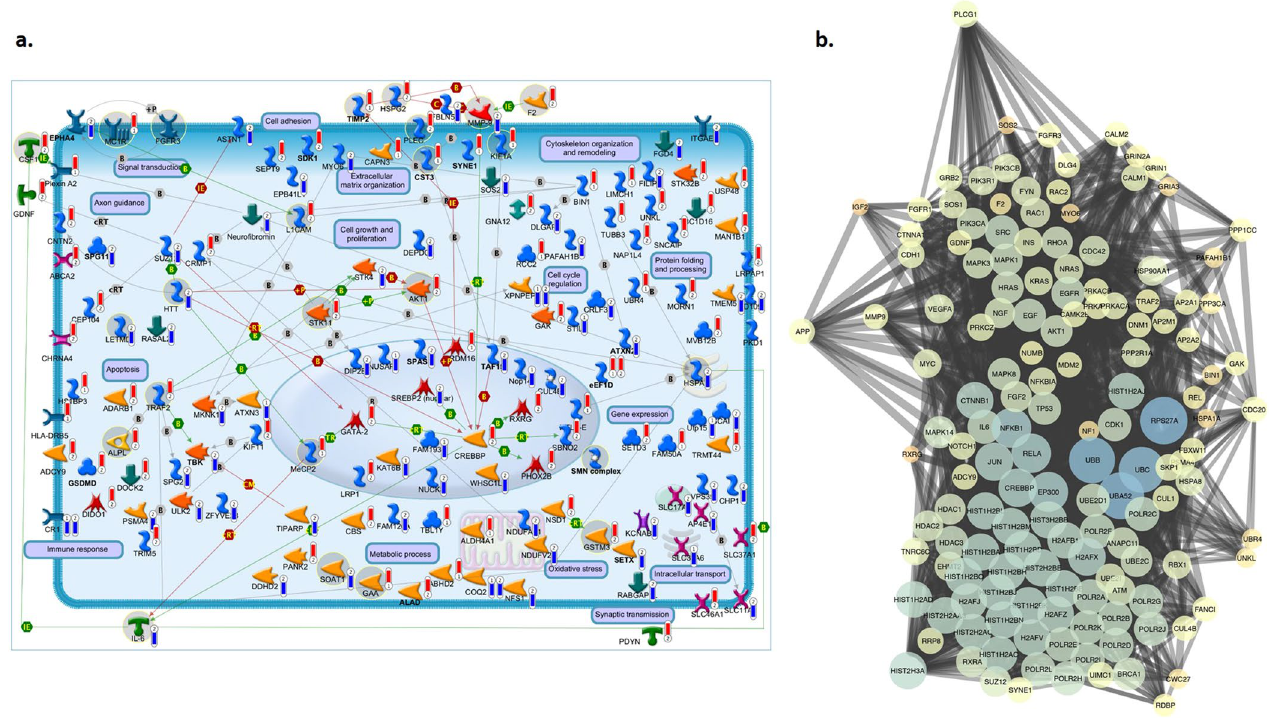
Figure 4. Definition of SALS subtype-specific genomic signature using pathway and network analyses. ( a ) A representative illustration showing the functional correlation between SALS associated CNV-driven genes and their biological processes. Interaction map represents the most promising candidate genes showing a positive correlation between gene expression and underlying genomic changes, grouped on the basis of the main biological processes associated with them. The map was created using the MetaCore Pathway Map Creator tool (GeneGo). Gene expression and CNV values are presented on the map as ‘thermometer-like’ figures with SALS1 patients data represented as thermometer #1 and SALS2 patients as #2. Genes associated with overexpression and CNV gain regions are labeled with red dots while genes associated with downregulated expression and homozygous or heterozygous deleted CNVs are labeled with blue dots. A detailed legend for the network objects is shown in the Supplementary Fig. 1. ( b ) Functional network of known and predicted interactions of the most promising candidate CNV-driven genes. The network was produced by the Search Tool for the Retrieval of Interacting Genes/Proteins (STRING) v10 (http://string-db.org/) using default settings. Proteins are represented by spheres. Lines linking proteins indicate evidence for interactions: a red line indicates the presence of gene fusion (genes that are sometimes fused into single open reading frames); a green line – gene neighborhood (genes that reside within 300 bp on the same strand in the genome); a blue line – co-occurrence (gene families whose occurrence patterns across genomes show similarities); a purple line - experimental evidence (interaction extracted from protein-protein interaction databases); a yellow line – text mining (interaction extracted from scientific literature); a light blue line - database (interaction extracted from curated databases); a black line – co-expression (proteins whose genes are co-expressed in the same or in other